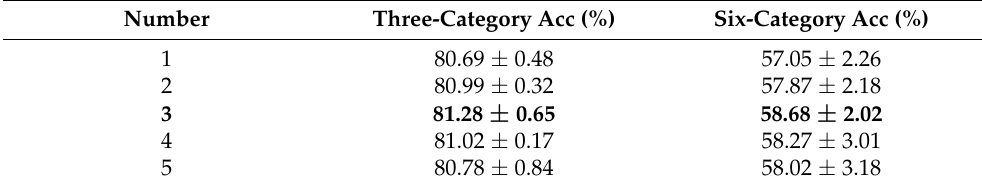
Table 12. Results on Different Numbers of